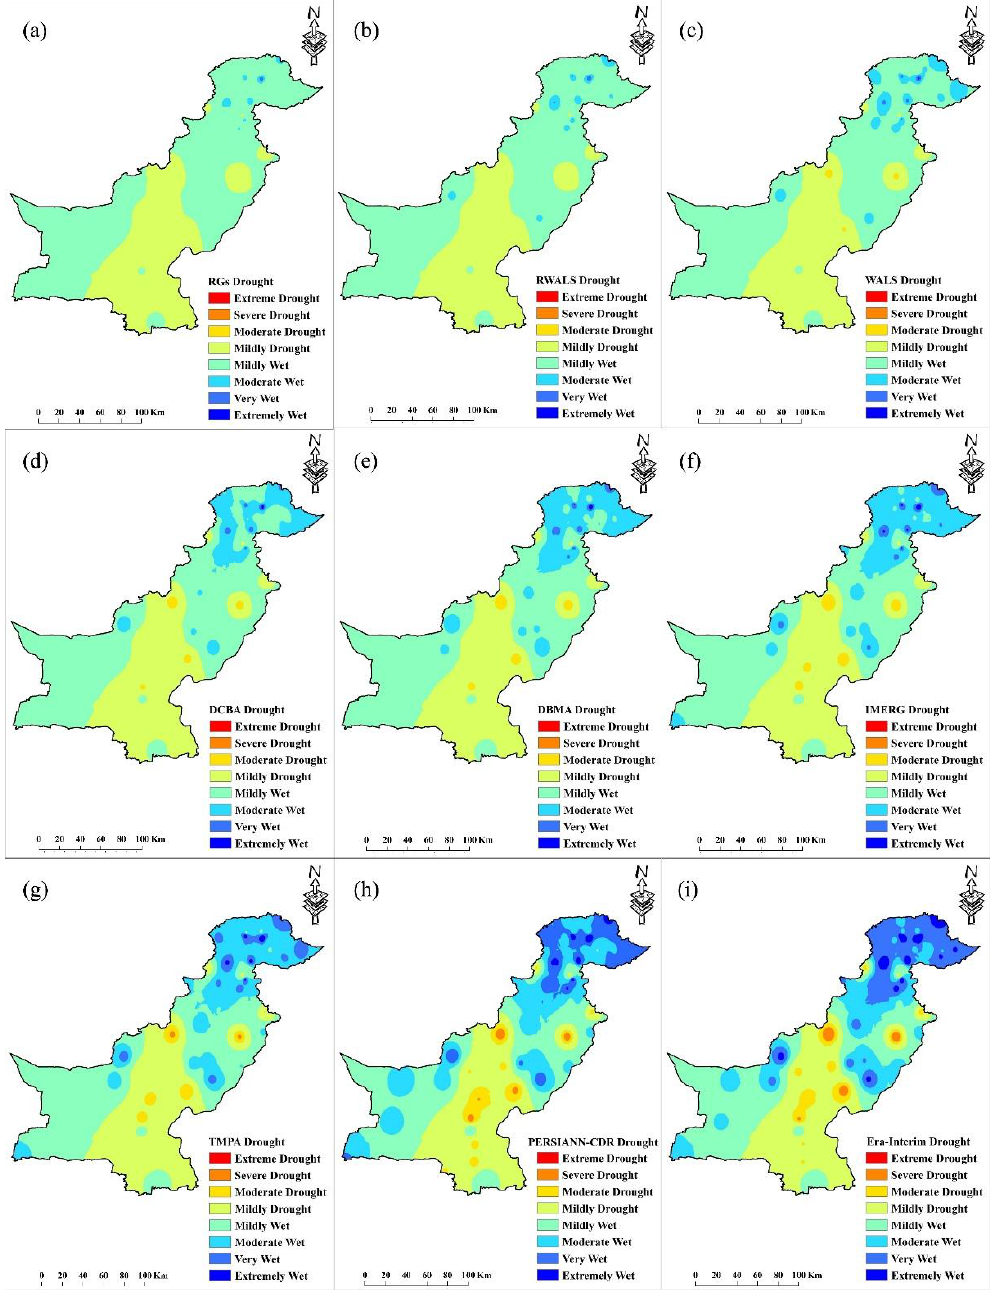
Figure 3. Spatial distribution of drought index (SPI-3) across Pakistan during the monsoon season in the representative drought year (2008), ( a ) RGs, ( b ) RWALS-MSPD, ( c ) WALS-MSPD, ( d ) DCBA-MSPD, ( e ) DBMA-MSPD, ( f ) IMERG, ( g ) TMPA, ( h ) PERSIANN-CDR, and (i) ERA-Interim.